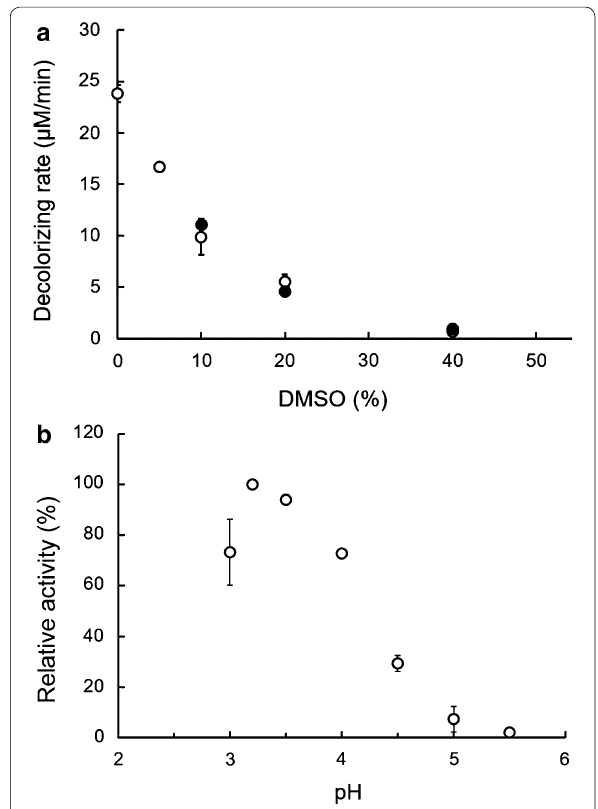
Fig. 1 Effects of solvent and pH on DyP activity. a Relationship between DyP activity and DMSO concentration. Open and closed symbols denote the degradation activity of recombinant DyP towards RB19 and alizarin, respectively. b pH profile of the activity of recombinant DyP toward alizarin